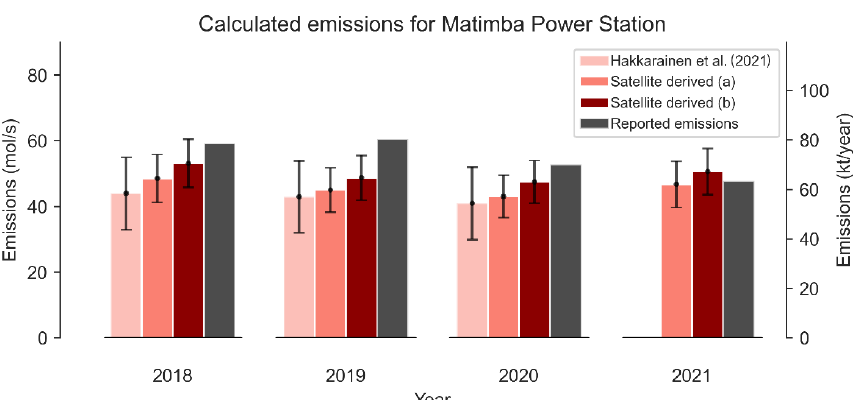
Figure 12. Comparison of emission estimates from TROPOMI NO x using different applications of the EMG method, values obtained by Hakkarainen et al. (2021) for the same site, and emissions reported from estimates by the operator, Eskom (https://www.eskom.co.za/ dataportal/emissions/ael/matimba-c2/, last access: 1 July